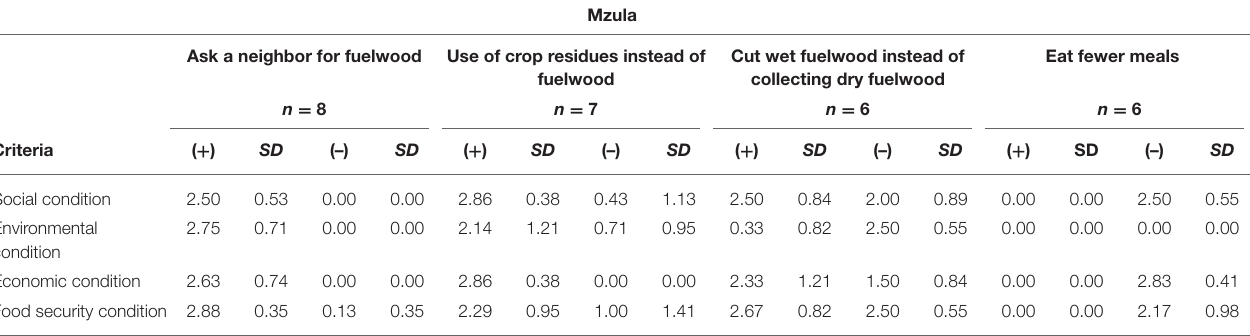
TABLE 4 | Results of the impact assessment of Mzula with the positive ( + ) and negative (–) ratings. Ask a neighbor for fuelwood Use of crop residues instead of